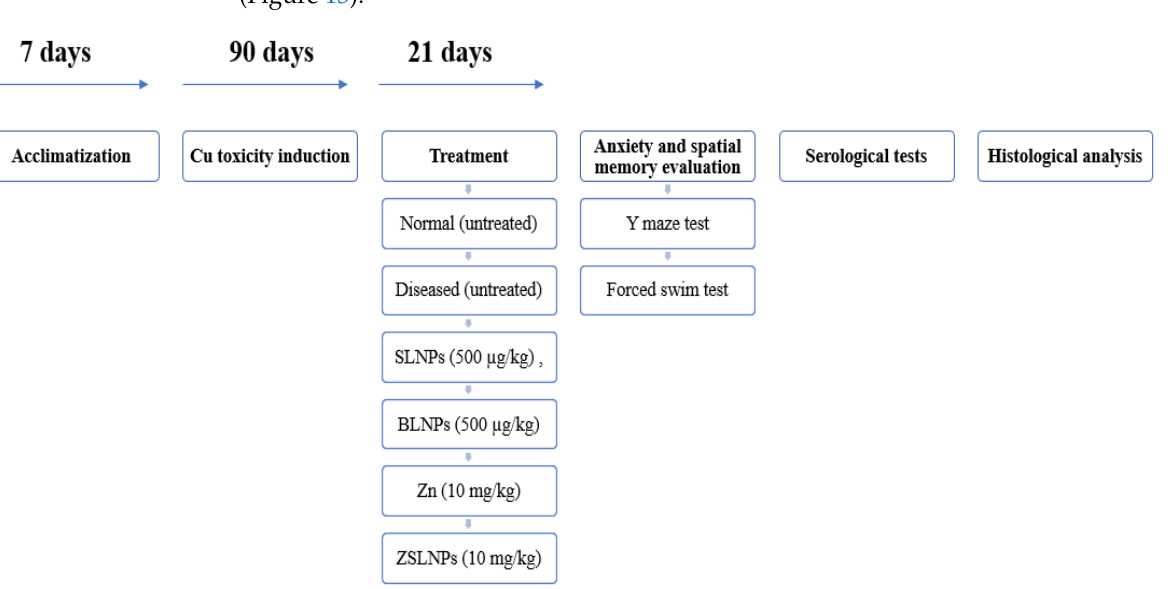
Figure 13. Flow chart showing study design from acclimatization, induction, treatment till analy- sis.